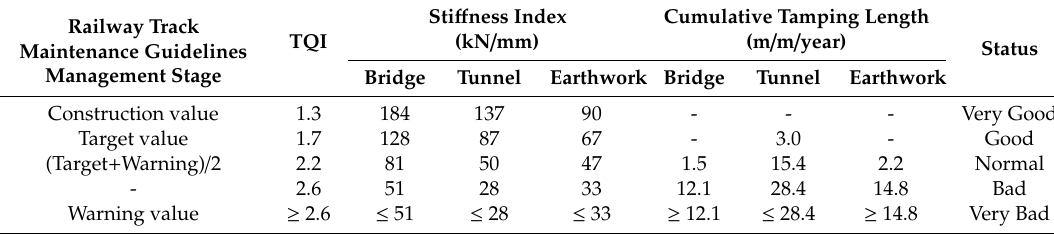
Table 7. Track status evaluation